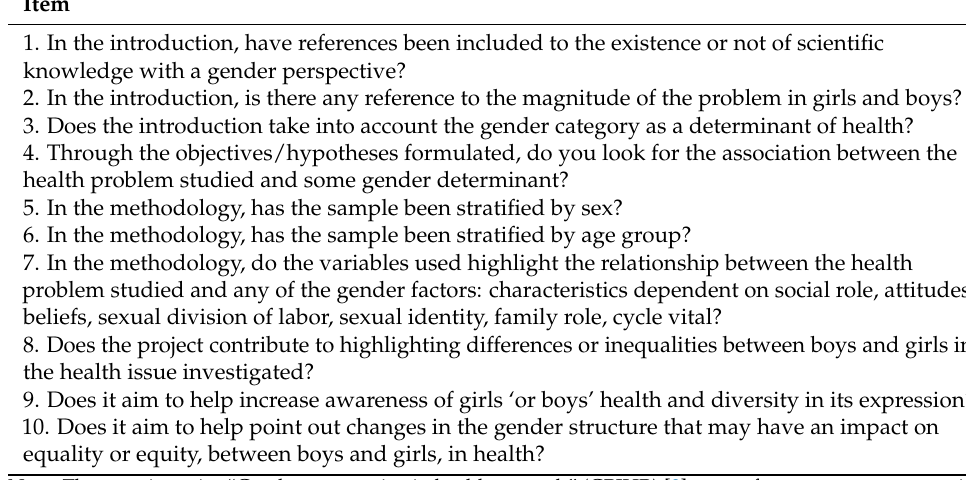
Table A2. Items adapted from the questionnaire “Gender perspective in health research” (GPIHR) [8].